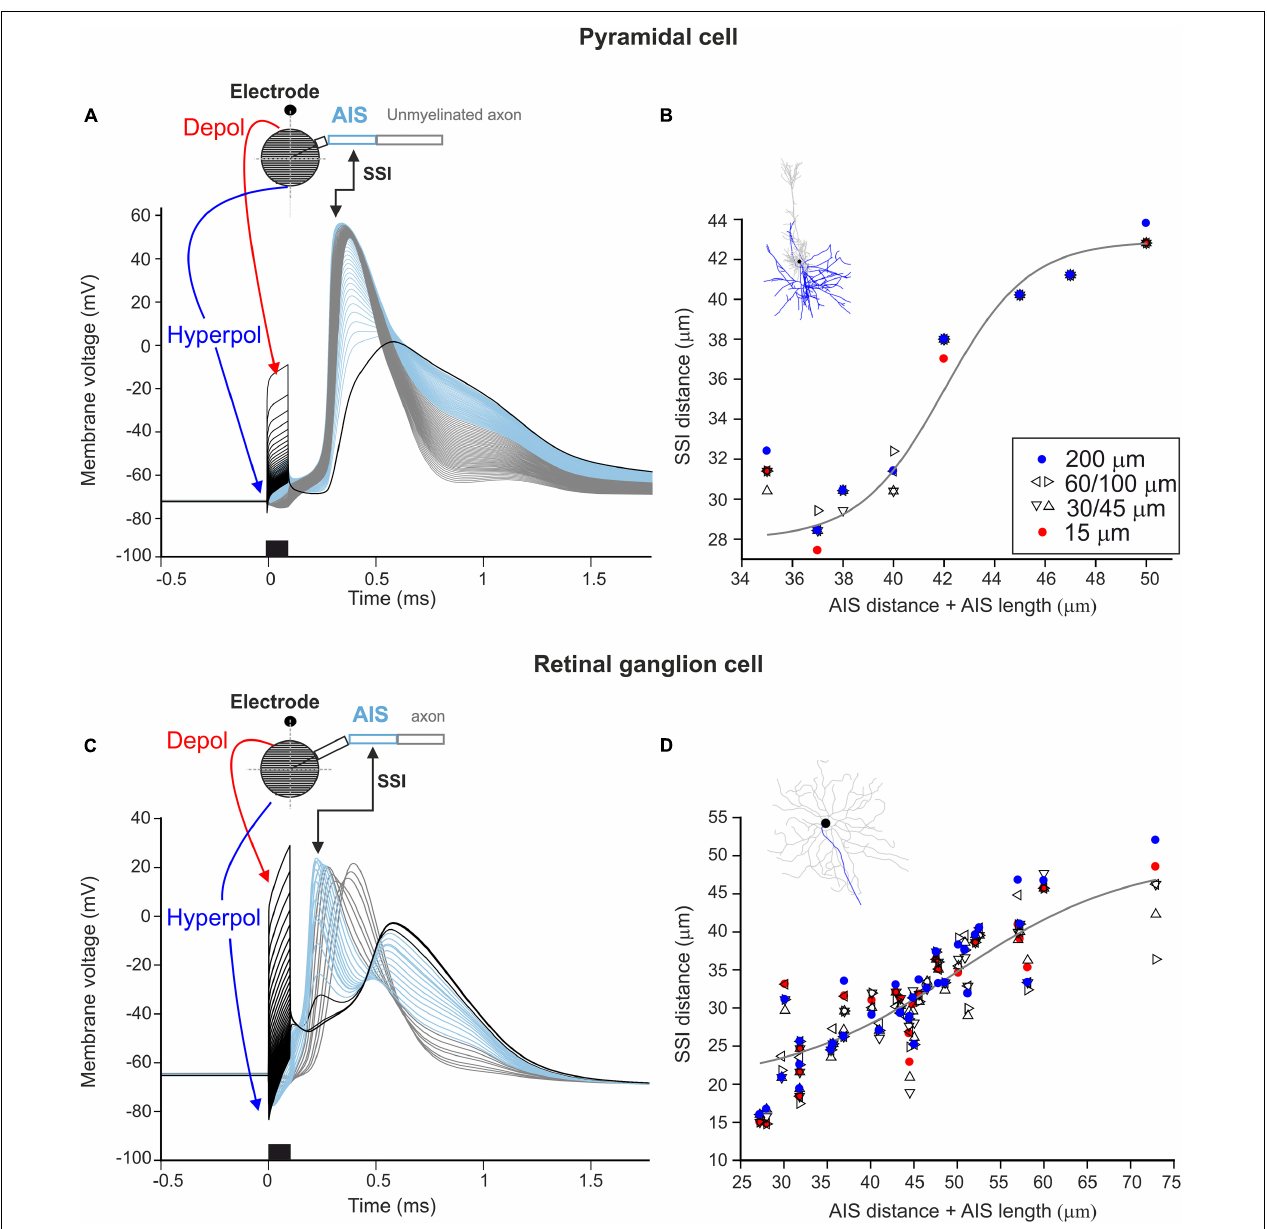
FIGURE 4 | Site of spike initiation in AIS for point source stimulation. (A) Membrane voltage of 41 soma compartments (black lines), AIS compartments (blue), other axon compartments (gray) as a function of time. The black kinked arrow indicates the site of spike initiation (SSI). The red and blue arrows show the location of soma compartments which are de- and hyperpolarized most strongly. The stimulus (cathodic, 0.1 ms) is shown at the bottom, the point source electrode was located 15 µ m above the soma. (B) For all electrode distances of the eight PCs, the distance between the soma and the site of spike initiation is plotted versus the distance between the soma and the distal end of the AIS (i.e., AIS distance + AIS length). The gray curve indicates the best-fit logistic function ( r 2 = 0.91). (C) Same as panel (A) for a representative RGC model neuron. (D) Same as panel (B) for 34 RGCs, the gray curve indicates the best-fit logistic function ( r 2 =